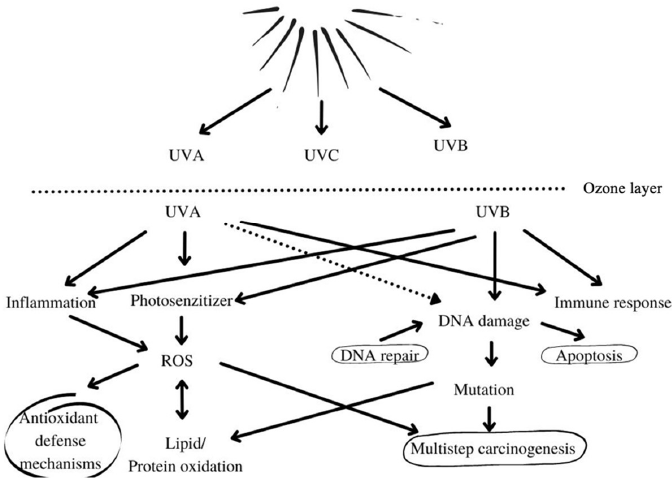
Figure 1. Action of UV radiation on the cellular biomolecules (modified from [5]).